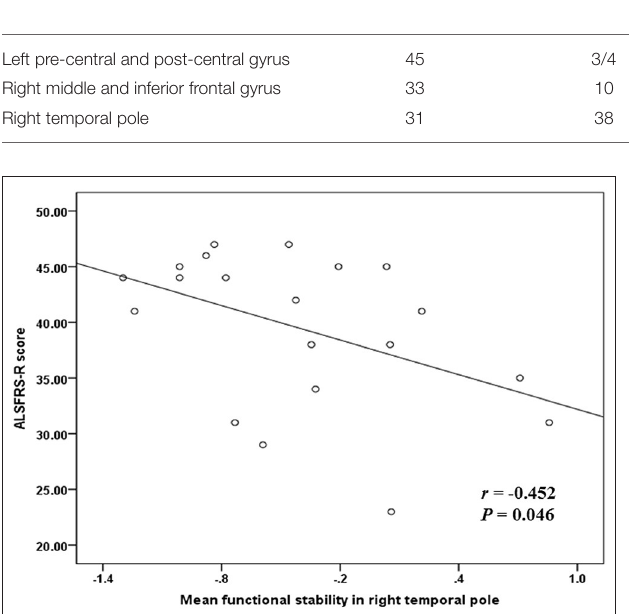
FIGURE 3 | The correlation between functional stability and disease severity reflected by ALSFRS-R score. ALSFRS-R, revised ALS Functional Rating